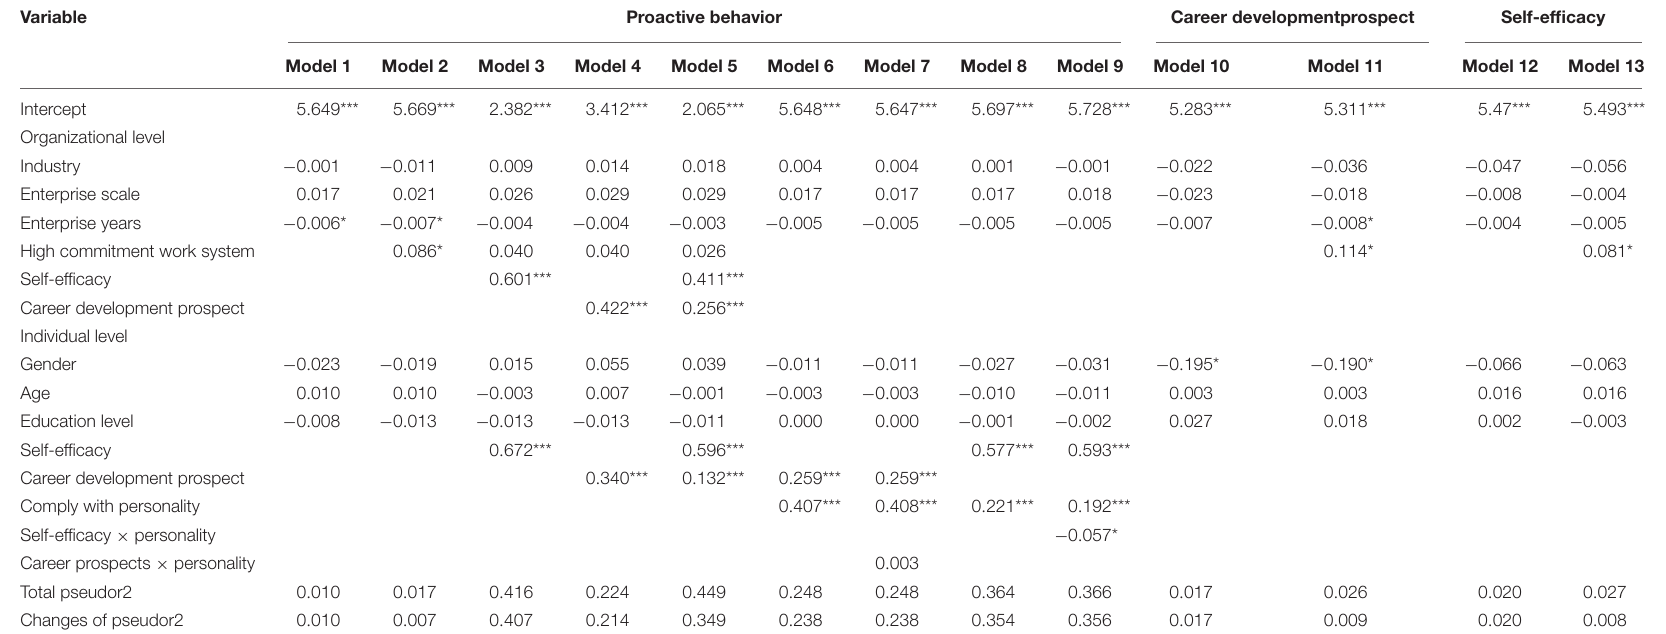
TABLE 3 | Regression results for testing